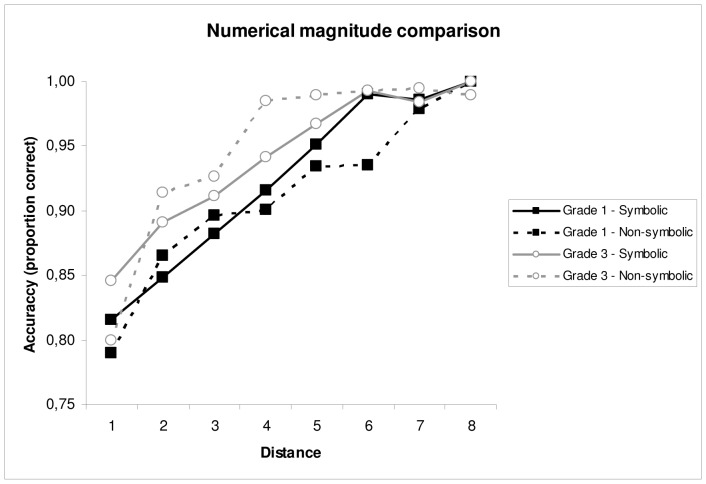
Mean accuracy on the numerical magnitude comparison tasks as a function of grade and distance.Solid lines indicate data on the symbolic magnitude comparison task (M
Grade 1 = .89; M
Grade 3 = .92), and dashed lines indicate data on the non-symbolic magnitude comparison task (M
Grade 1 = .88; M
Grade 3 = .92).